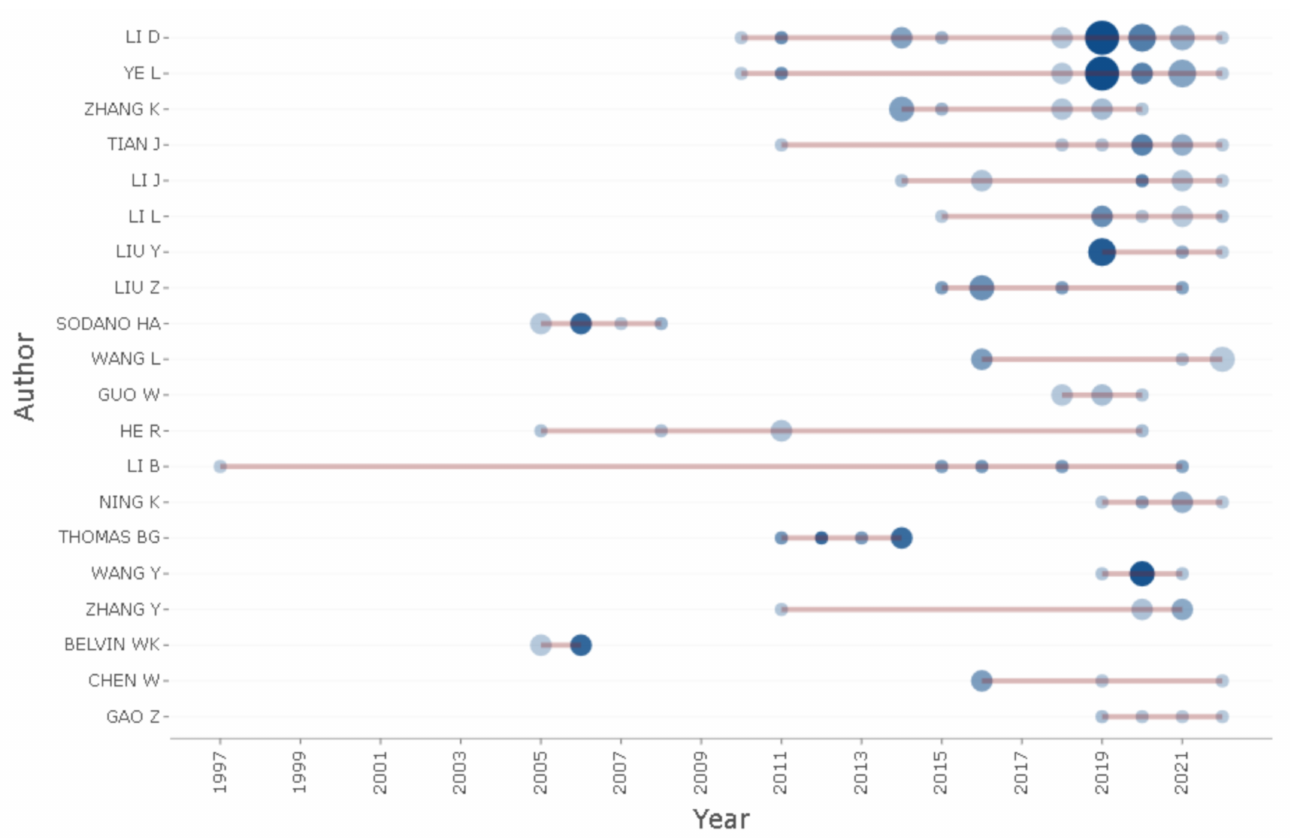
Figure 1. Annual scientific production of eddy current brake for heat generation.